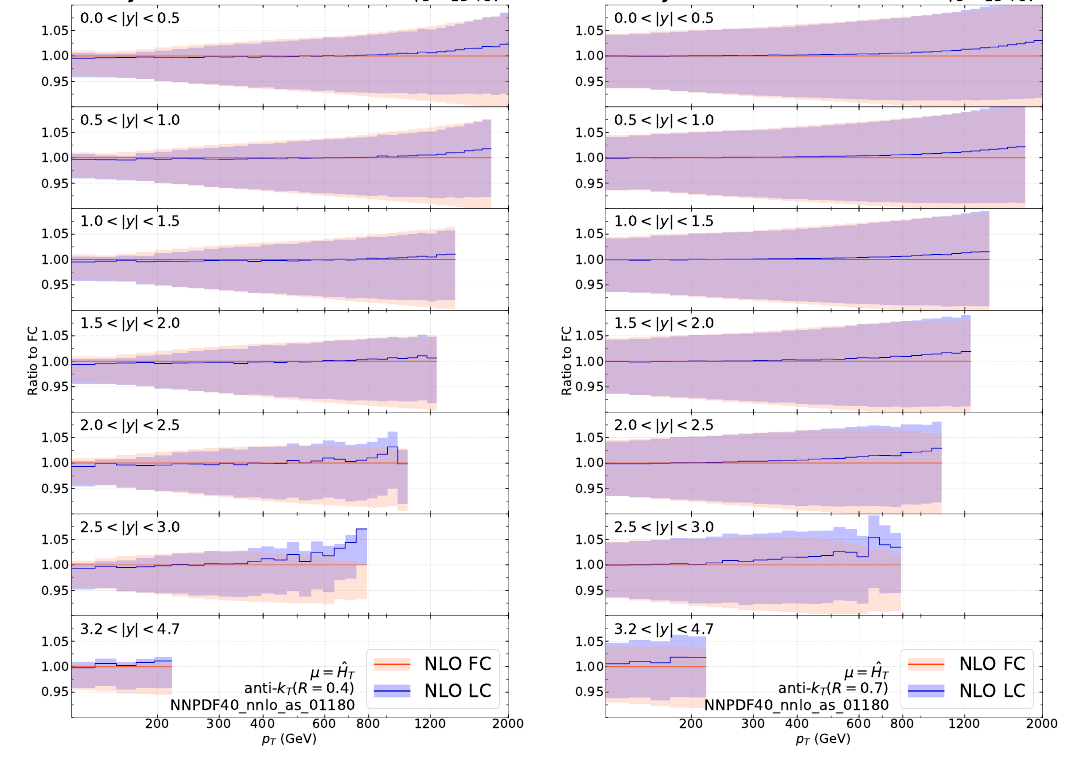
Figure 4 . NLO predictions at LC (blue) and FC (red) predictions of the R = 0 . 4 (left) and R = 0 . 7 (right) single jet inclusive cross section as function of p T for all the considered rapidity slices, normalized to the FC